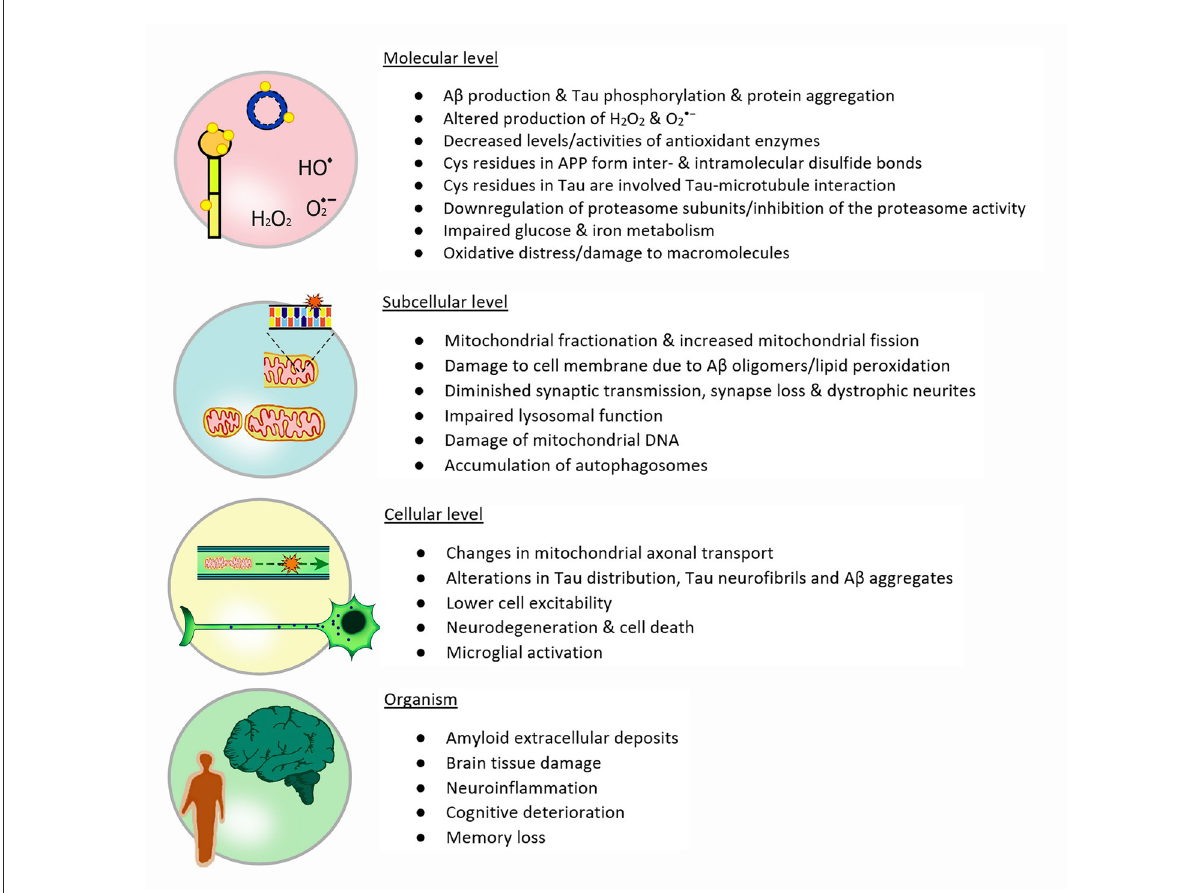
FIGURE3 Redox metabolism in AD: The illustration depicts the four different levels of redox and metabolic changes in Alzheimer’s disease: Molecules involved and their importance, different subcellular and functional changes, cellular alterations and finally the impact on the whole organism and particularly in patients. Each stage presents features that are a direct or indirect consequence of events described in the previous